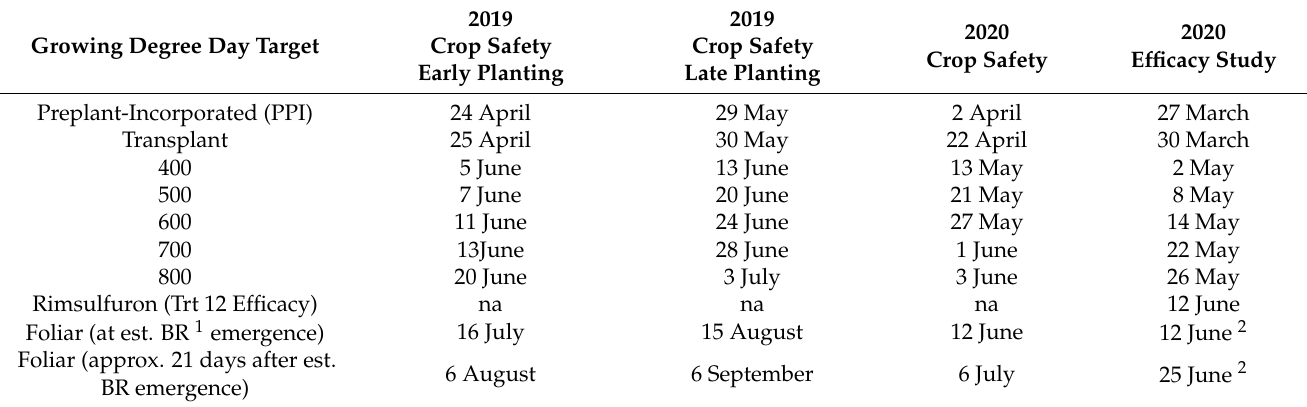
Table 6. Growing degree day targets and actual herbicide application dates in crop safety and branched broomrape efficacy studies in processing tomatoes in Yolo County, CA,